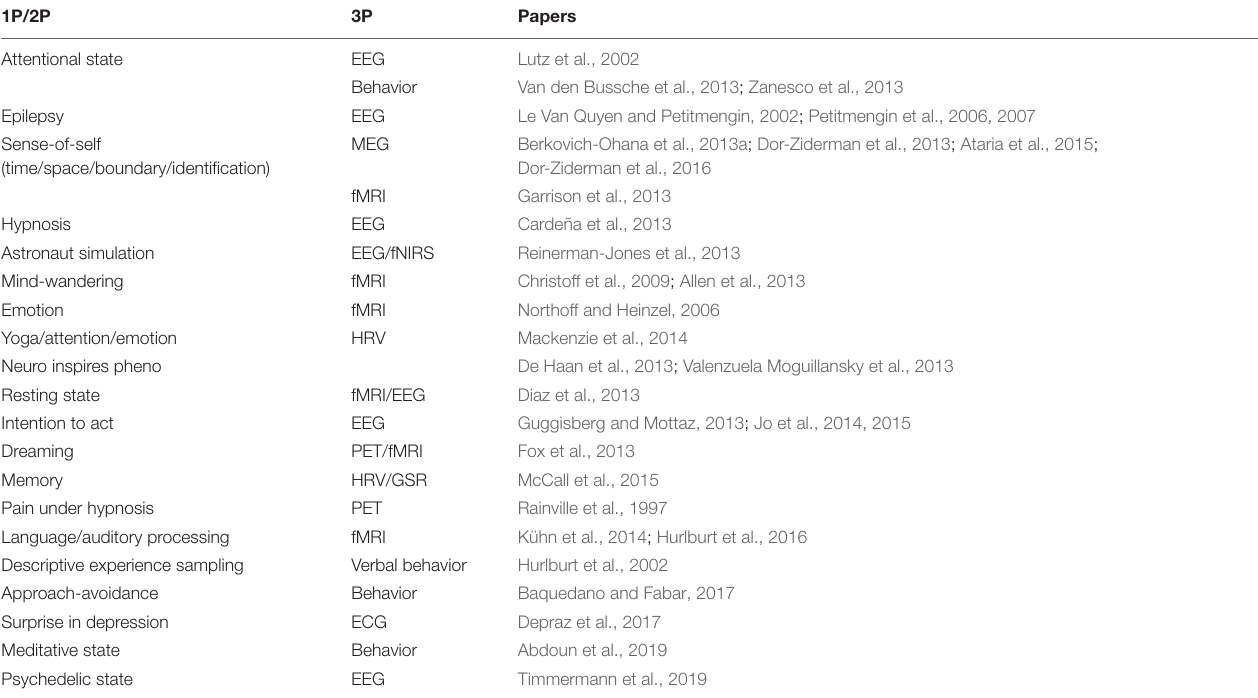
TABLE 2 | A list of papers employing neurophenomenological empirical